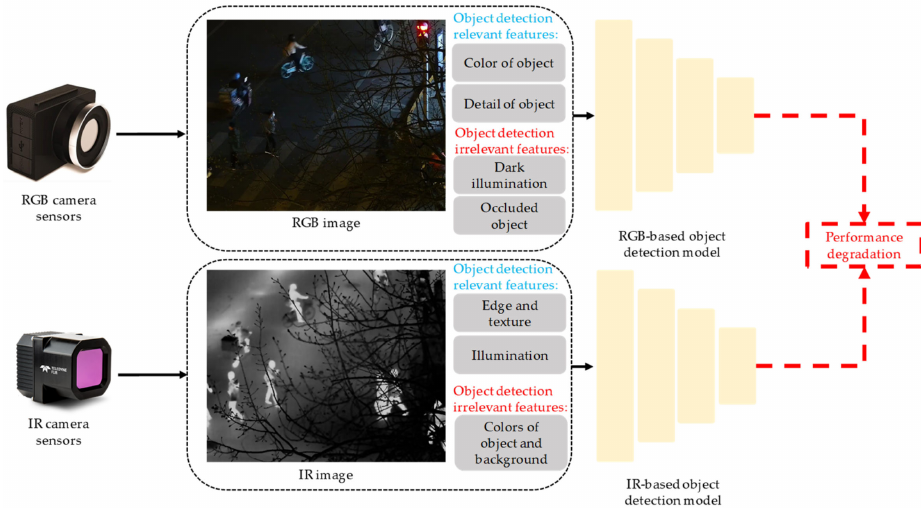
Figure 2. Problems with RGB- or IR-based object detection